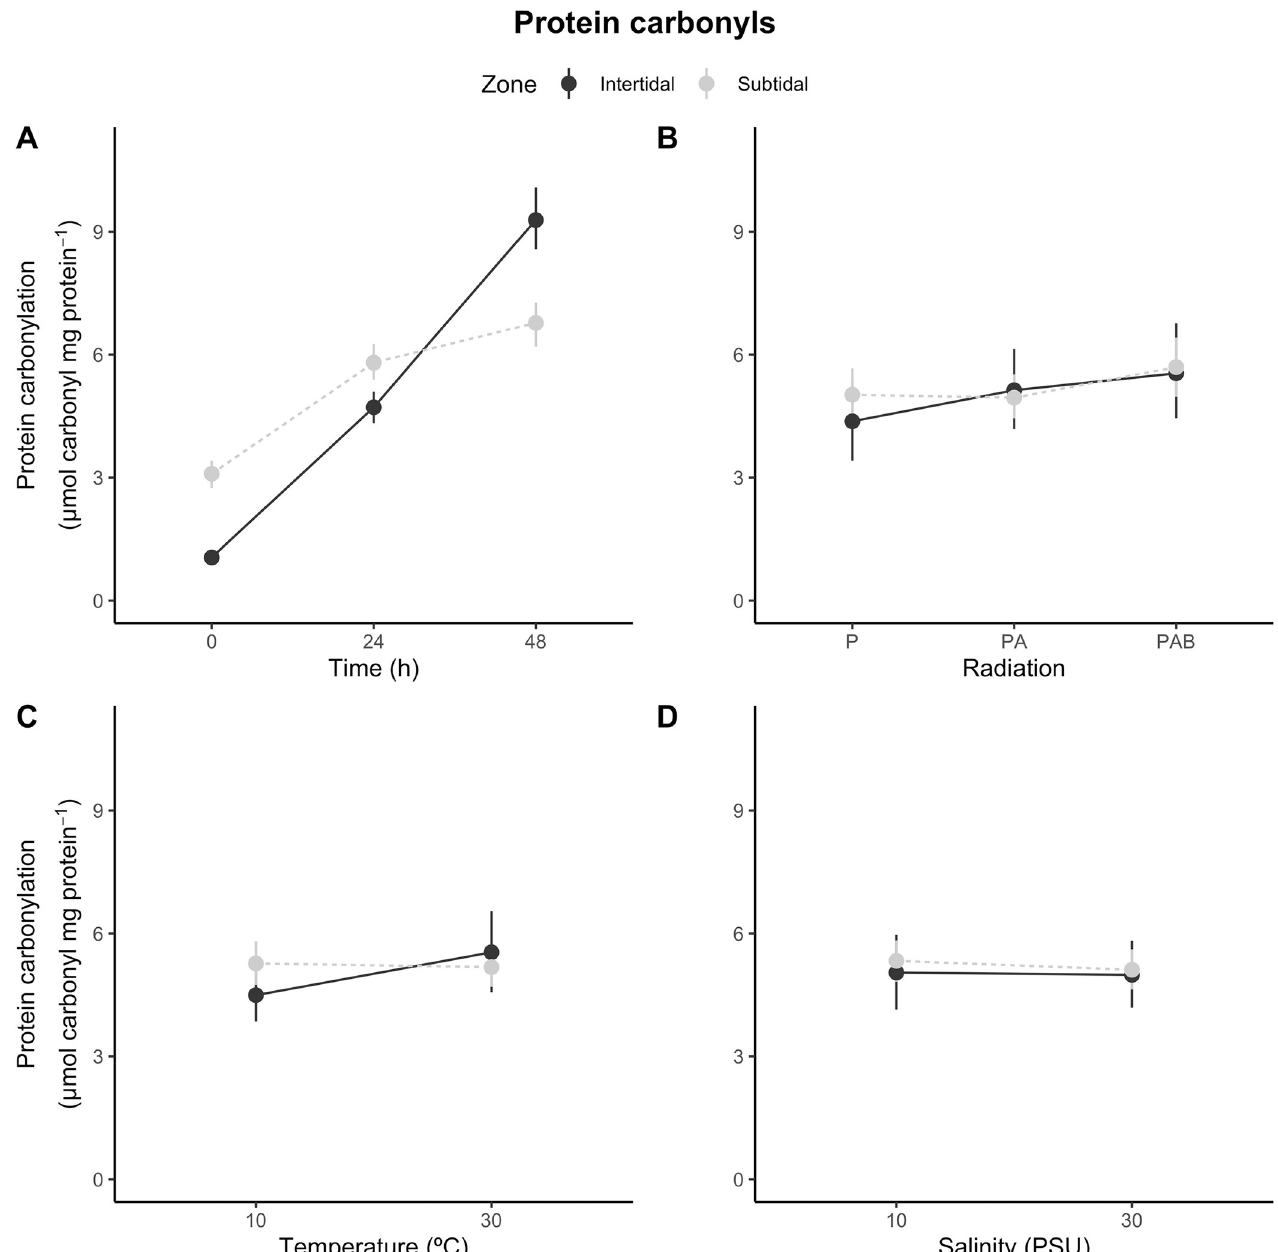
Fig 4. Anthopleura hermaphroditica . Protein carbonyl levels: zone-dependent responses of the estuarine anemone A . hermaphroditica to variations in (A) exposure time, (B) radiation treatment, (C) temperature and (D) salinity treatments. Values are provided as means ± confidence intervals (n = 4).